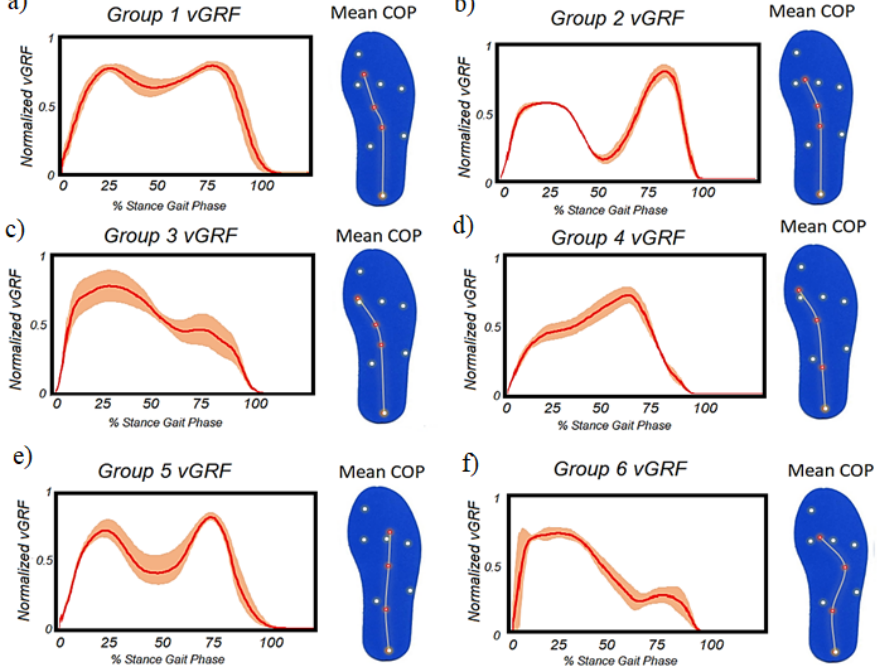
Figure 7. vGRF and COP average of each group. The continuous line is the mean of the one-minute test, and the shadows are one standard deviation of the group. The COP chart is marked with the transition of each gait: ( a ) Group 1, ( b ) Group 2, ( c ) Group 3, ( d ) Group 4, ( e ) Group 5, and ( f )